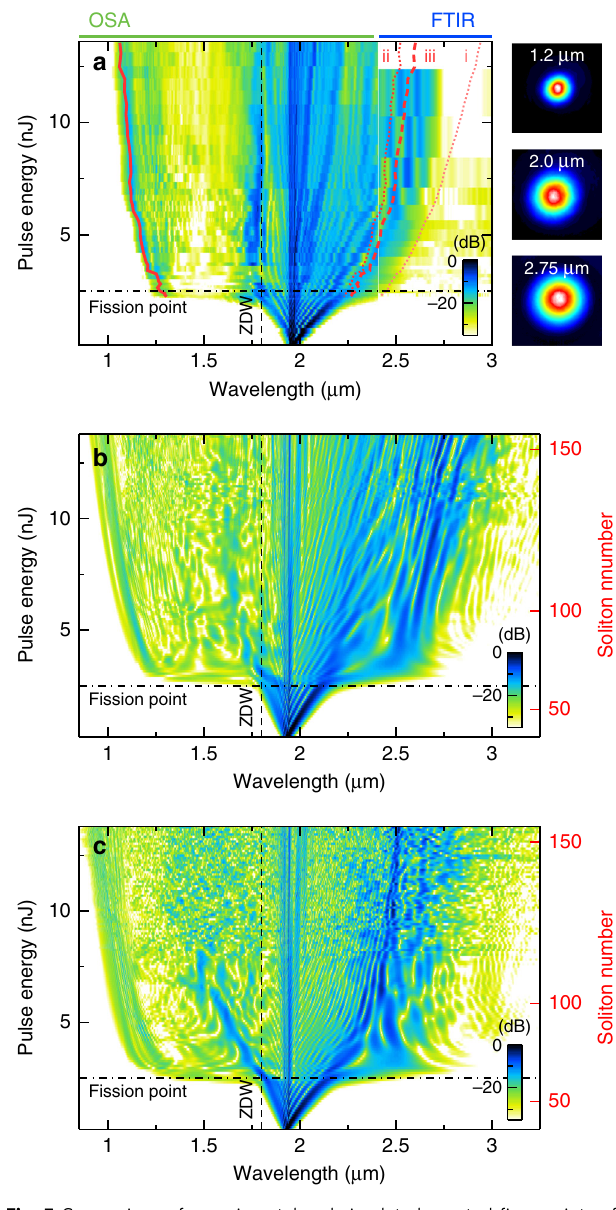
Fig. 5 Comparison of experimental and simulated spectral fi ngerprints of generated supercontinua. a Measured output spectra (log. power scale: − 35 to 0 dB) of the CS 2 /silica LiCOF for increasing pulse energy. Red lines : measured spectral position of the dispersive wave with the lowest wavelength (solid) and the phase-matched wavelengths of the fi rst fundamental solitary wave for the three different nonlinear phase shifts (numbers correspond to the cases discussed in the main text). The right- handed insets show the measured near- fi eld pro fi les at three selected wavelengths (pulse energy 8 nJ). OSA optical spectral analyser, FTIR Fourier transform infrared spectrometer, ZDW zero-dispersion wavelength. b Simulated single-pulse spectra (GNLSE) for increasing input pulse energy (log. power scale: − 35 to 0 dB), using a pulse shape reconstructed from the experiment, and the full temporal response of CS 2 . c Simulated single-pulse spectra for increasing input pulse energy (log. power scale: − 35 to 0 dB),